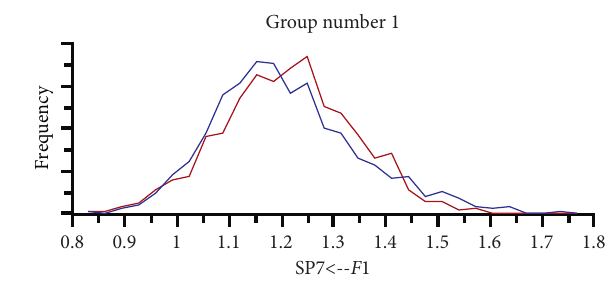
Figure 10: First and last combines polygon SP7.